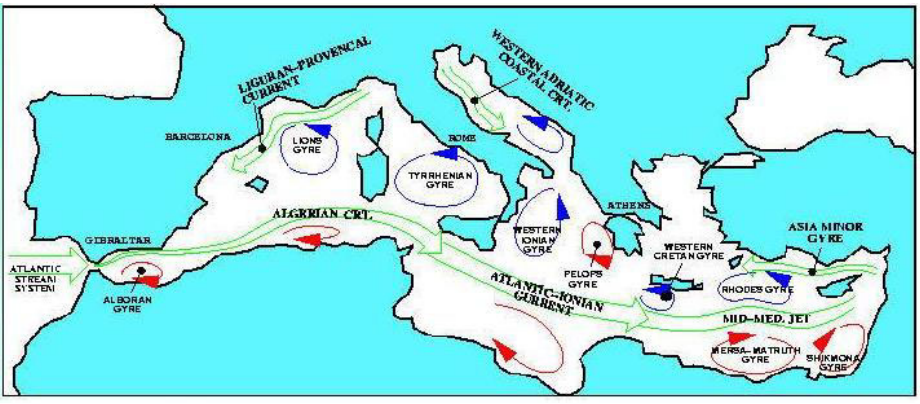
Fig. 2. Schematic of the main features of the general circulation in the Mediterranean, after Roussenov et al.